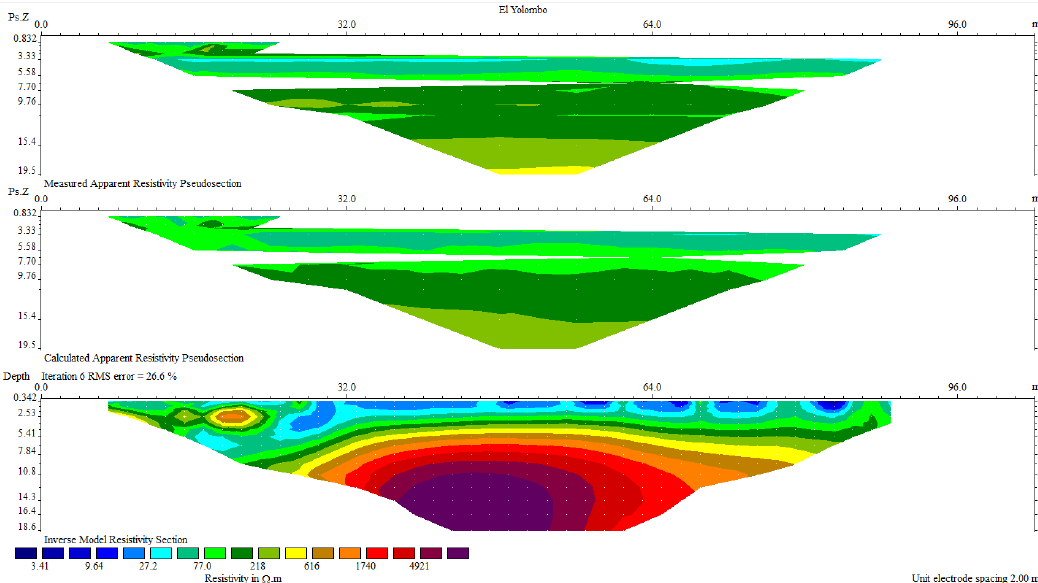
Figure 7. Construction of the tomographic section along the maximum slope of the study site (green line in Figure 1). Top panel shows the apparent resistivity pseudosection with the data measured in the field; middle panel shows the pseudosection with the predicted apparent resistivities that would correspond to the preferred model obtained from inversion; bottom panel shows the result of the inversion, the resistivity model that best fits the data. The RMS of the residuals, given in percentage, is 26.6.